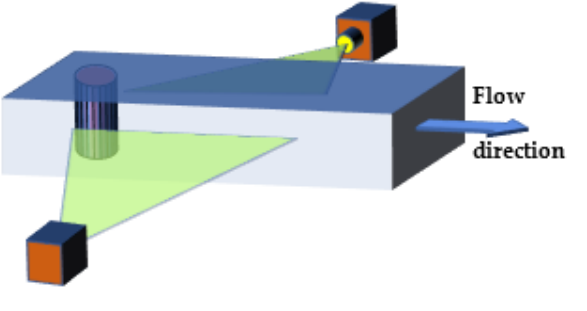
Figure 16. Experimental section.